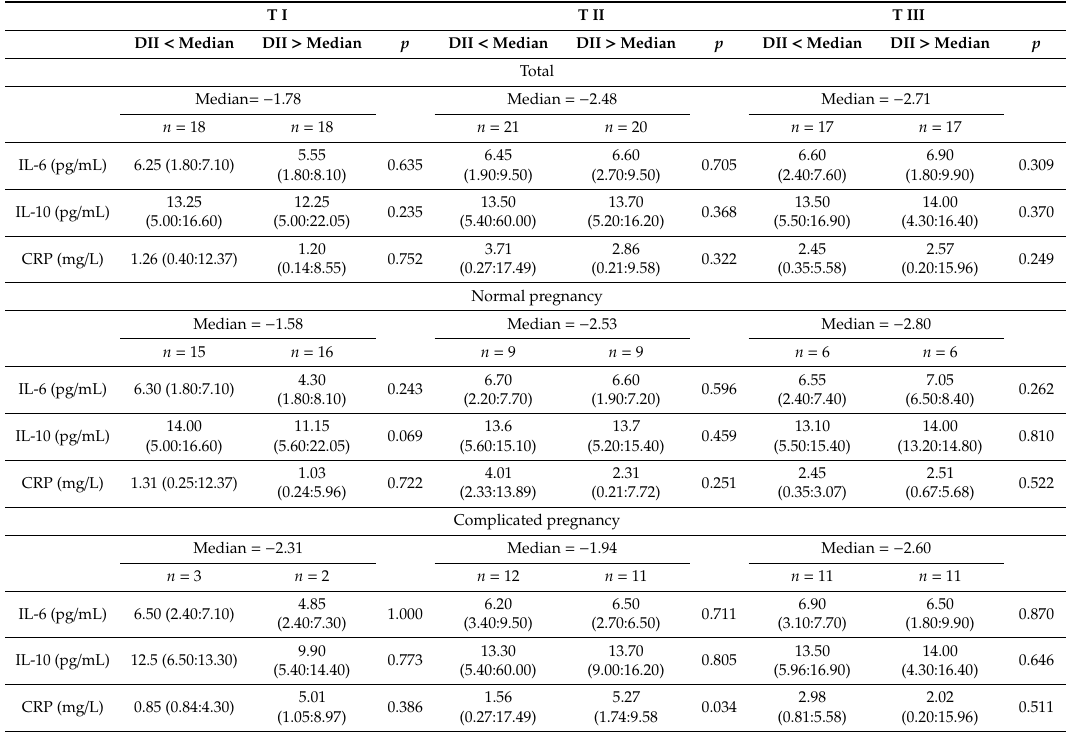
Table 3. Comparison of serum concentrations of IL-6, IL-10, and CRP depending on the median value of the DII score during pregnancy, median (min:max).